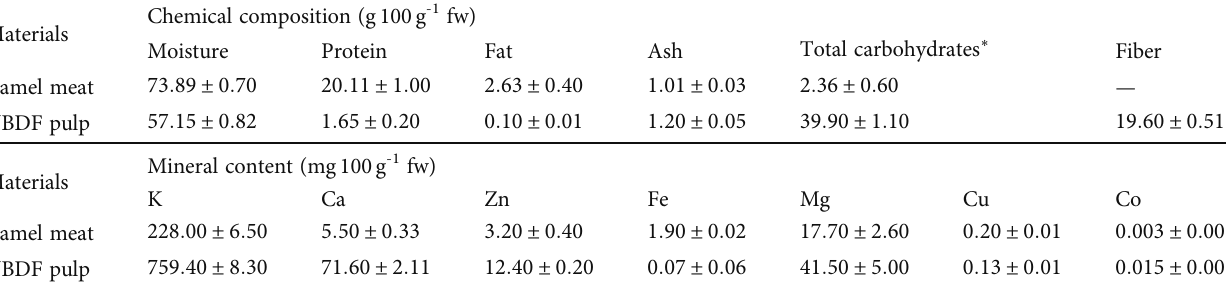
Table 2: Chemical composition and mineral content of raw